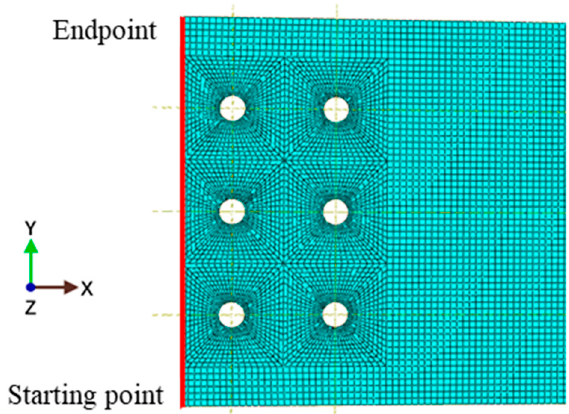
Figure 11. Deformation of X-direction riveted sheet.